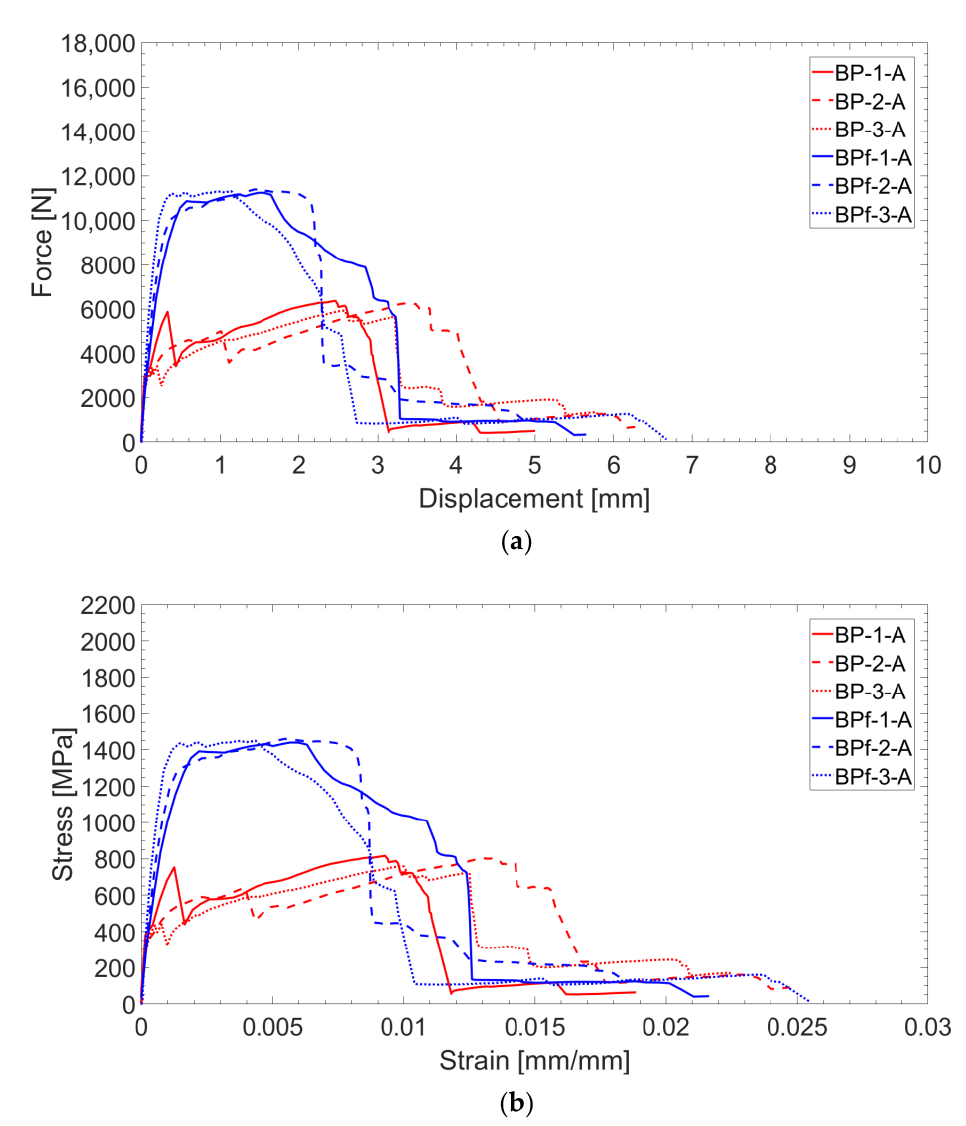
Figure 4. Force – displacement ( a ) and stress – strain ( b ) curves of B-TRC and B-F/TRC